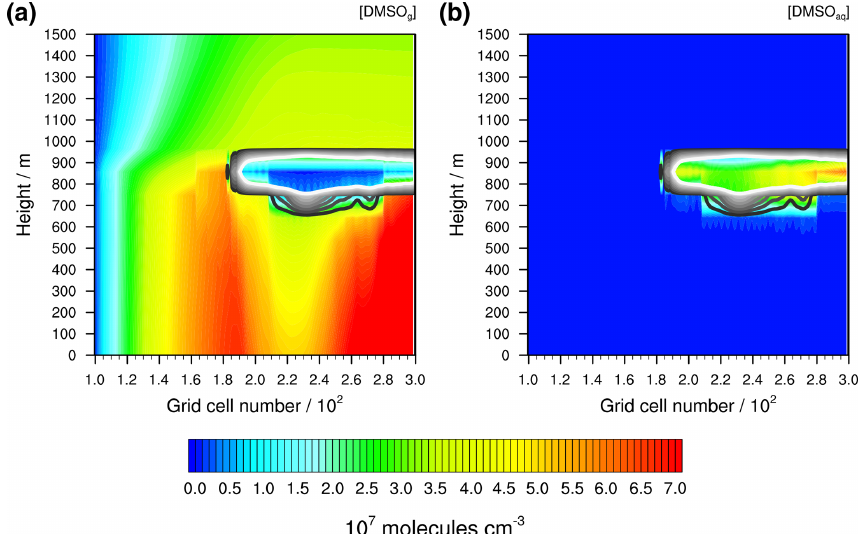
Figure 8. Simulated concentrations of DMSO (a) in the gas phase and (b) in the aqueous phase under the stable meteorological condition simulation with stratiform clouds after 12h of modelling time. The x axis represents the innermost horizontal grid cells divided by 100. The black contour lines represent the simulated clouds. The black line corresponds to a LWC of 0.01gm − 3 and the white line to 0.1gm − 3 . The area framed by the white line includes LWC above 0.1gm − 3